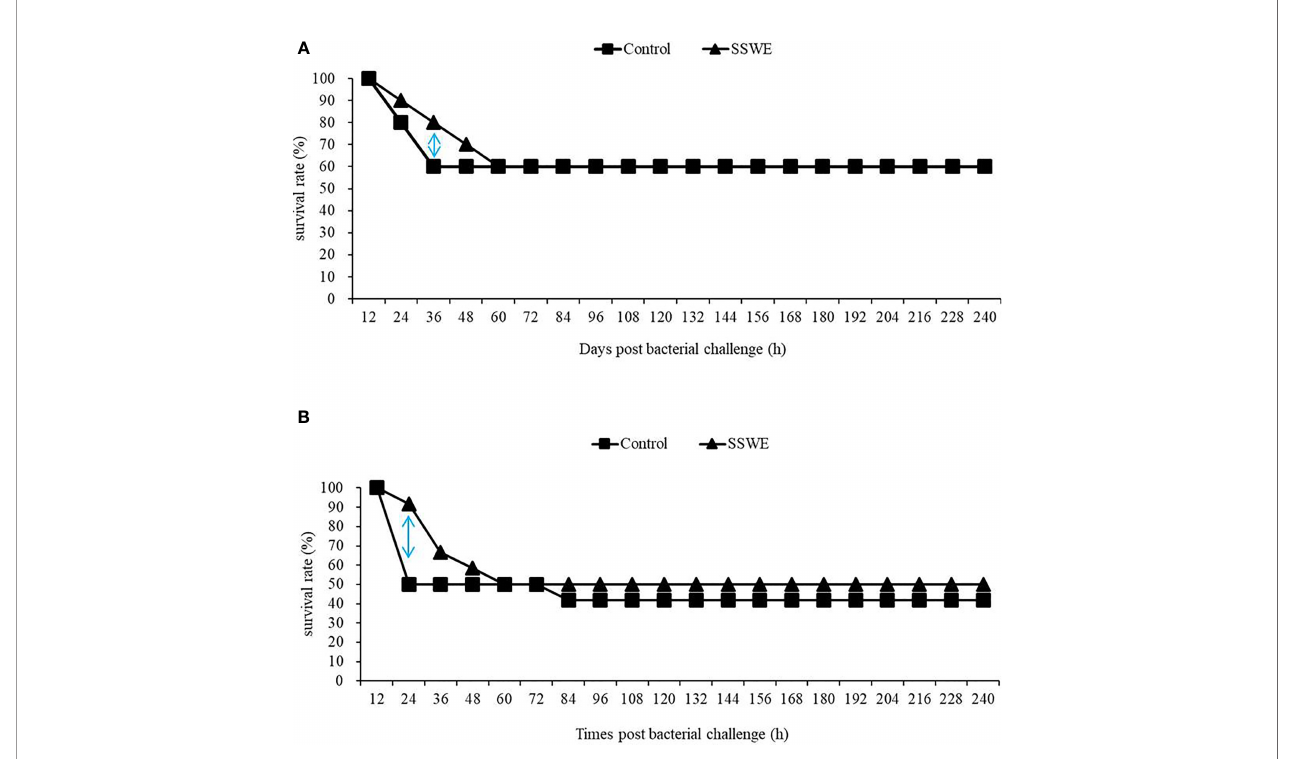
FIGURE 6 | Fish were injected with PBS or PBS containing Sarcodia suiae water extract (SSWE, 20 m g/g body weight (BW)) followed by challenge with (A) 4.5 × 10 6 CFU/g BW or (B) 1.2 × 10 7 CFU/g BW Photobacterium damselae subsp. damselae 8 h post SSWE injection. Survival percentage was recorded for 240 h N = 10 (A) or 12 (B) per